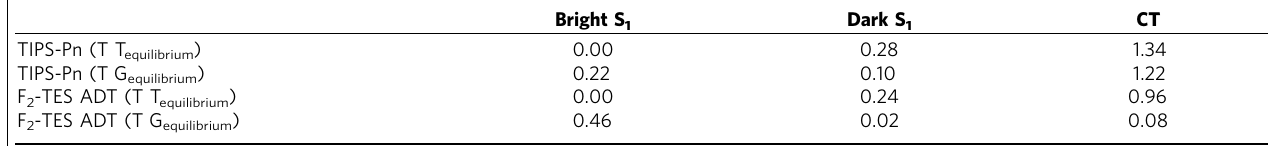
Table 1 | Diabatic mixing in 1 (TT).